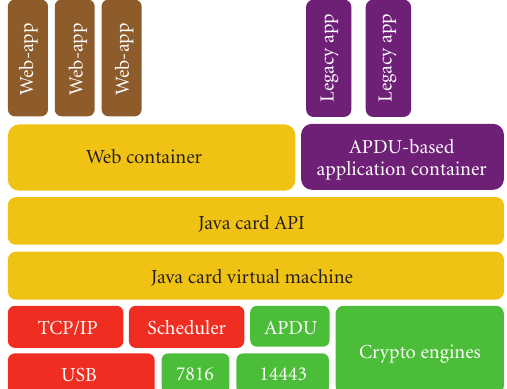
Figure 1: Functional architecture.